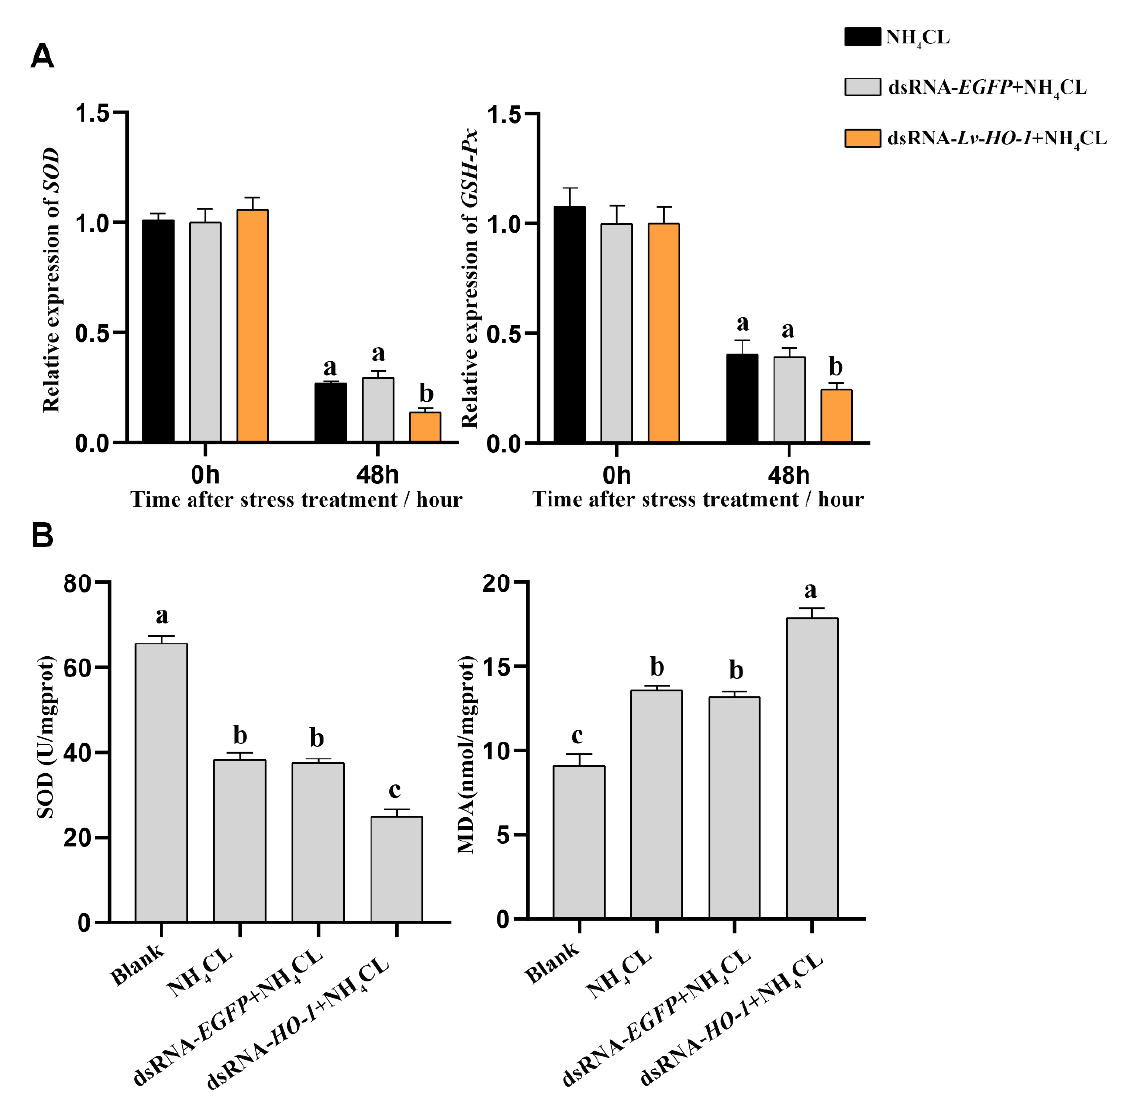
Figure 5. ( A ) Mn-SOD and GSH-Px in the hepatopancreas post-RNAi detected by qRT-PCR after ammonia-N stress. All values are the mean ± SD; n = 3. ( B ) The activities of SOD and the content of MDA in the hepatopancreas after ammonia exposure. Different letters indicate a significant difference ( p < 0.05). 3.6. Effect of Silencing Lv-HO-1 on Autophagy and Apoptosis Expression levels of autophagy genes including Atg3 , Atg4 , Atg5 , and Atg10 in the PBS